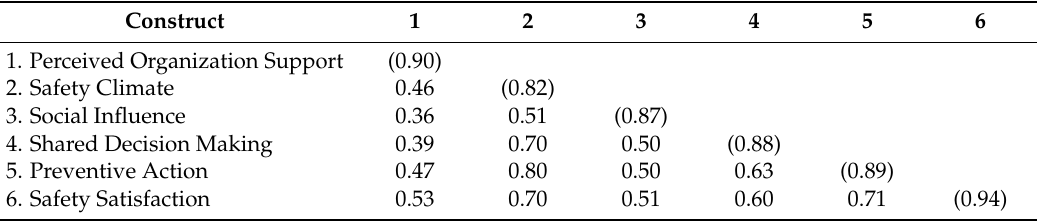
Table 3. Results of discriminant validity